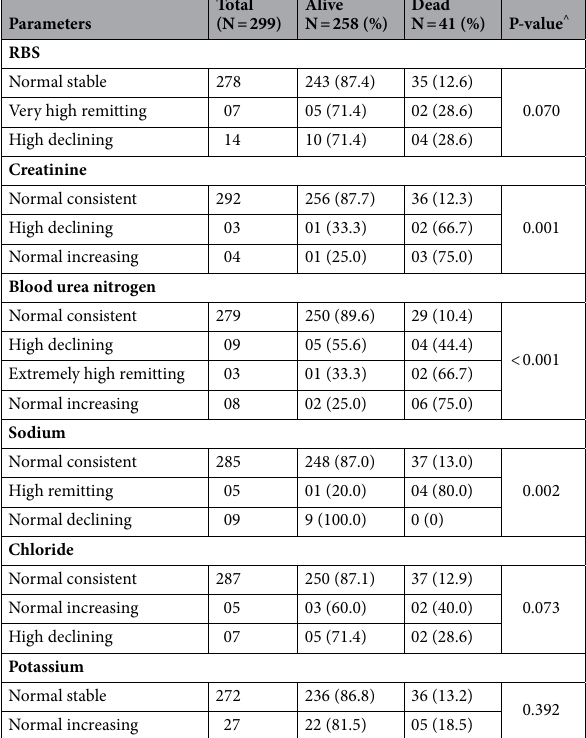
Table 2. ICU-mortality comparison of biochemical parameters—latent classes. ^ Fisher exact test.